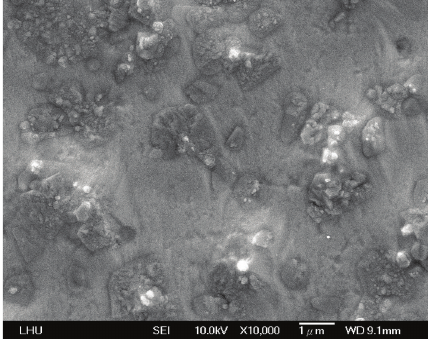
Figure 2: The surface morphology of the In/Cu-Ga